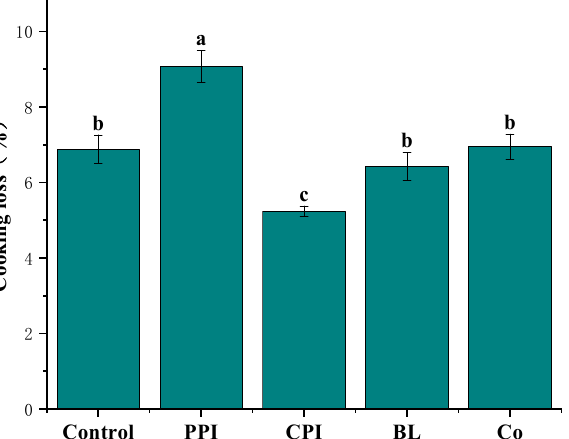
Figure 2. Effects of different protein pre-emulsified soybean oils on the cooking loss of fish sausage. Note: Different letters indicate that there is a significant difference between samples ( p < 0.05). The error bars represent the standard deviation ( n = 3).